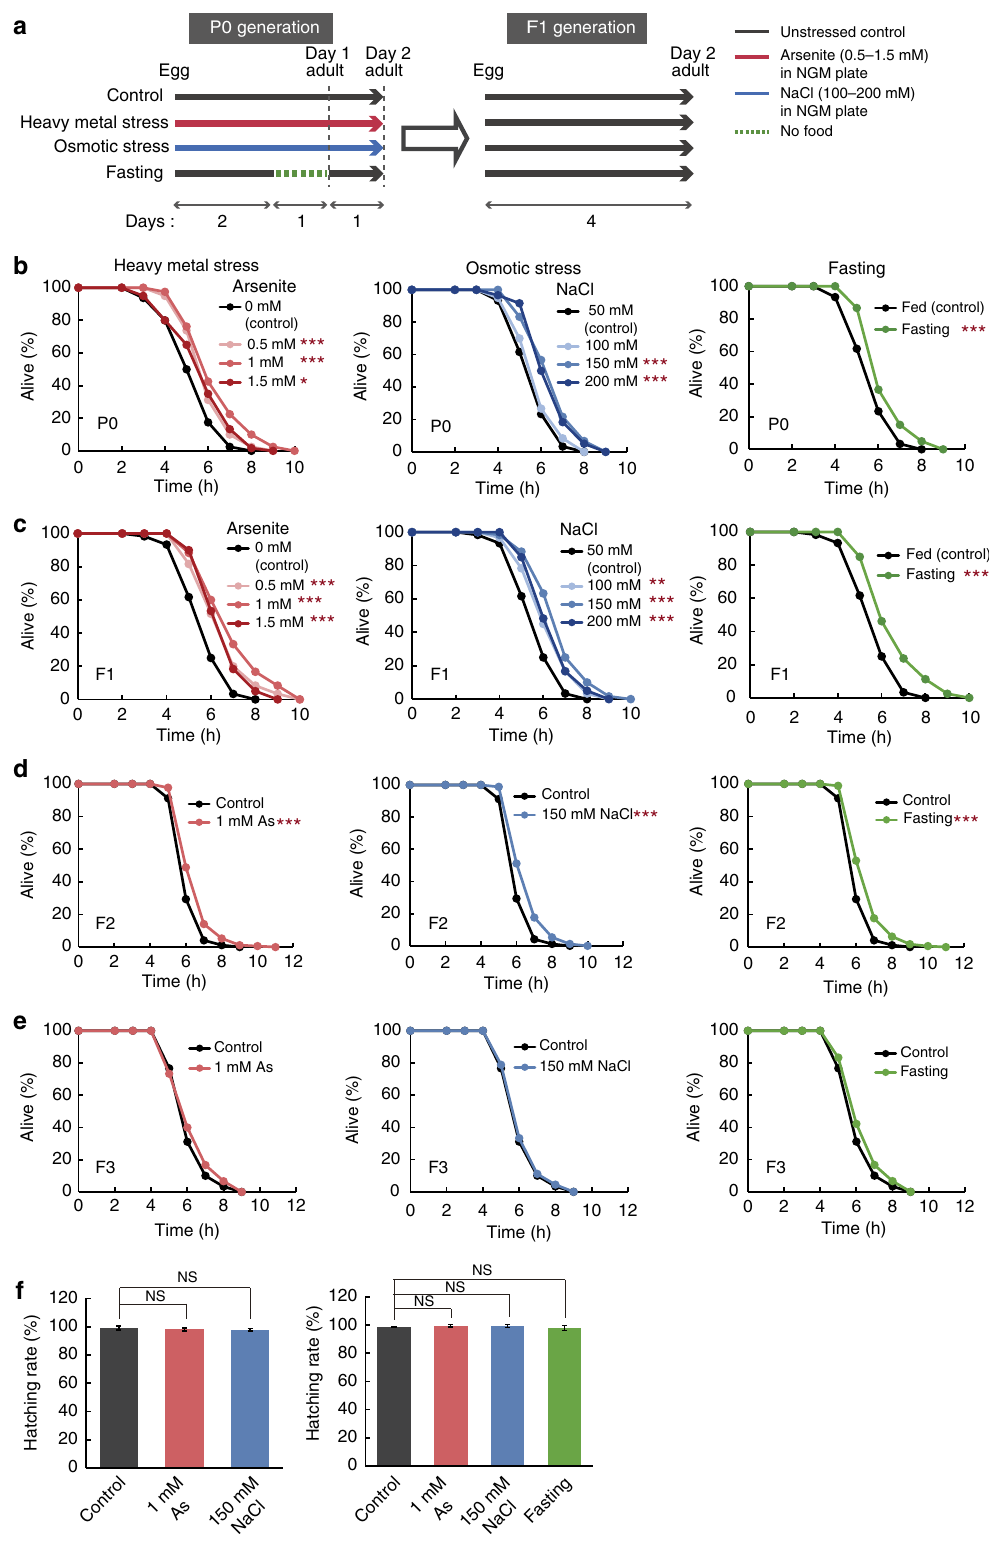
Figure 1 | Transgenerational inheritance of increased resistance to oxidative stress. ( a ) Scheme for exposure to environmental stressors. P0 parents were subjected to each stressor during developmental stages as indicated and the F1 descendants were raised under unstressed conditions. ( b – e ) Oxidative stress resistance of the stressed P0 parents ( b ), self-fertilized F1 ( c ) on day 2 adulthood in 2.3mM H 2 O 2 , F2 ( d ) and F3 ( e ) descendants on day 1 adulthood in 1.7mM H 2 O 2 compared with control groups. Three independent experiments are integrated into each survival curve. Statistical significance was calculated by log-rank test. * P o 0.05, ** P o 0.01, *** P o 0.005. Mean survival time and statistics are presented in Supplementary Table 1. ( f ) Hatching rate of the stressed P0 parents (left) and the F1 (right) descendants. Statistical significance was calculated by Student’s t -test. Error bars represent the mean ± s.d. of three independent experiments. NS, not significant; AS,